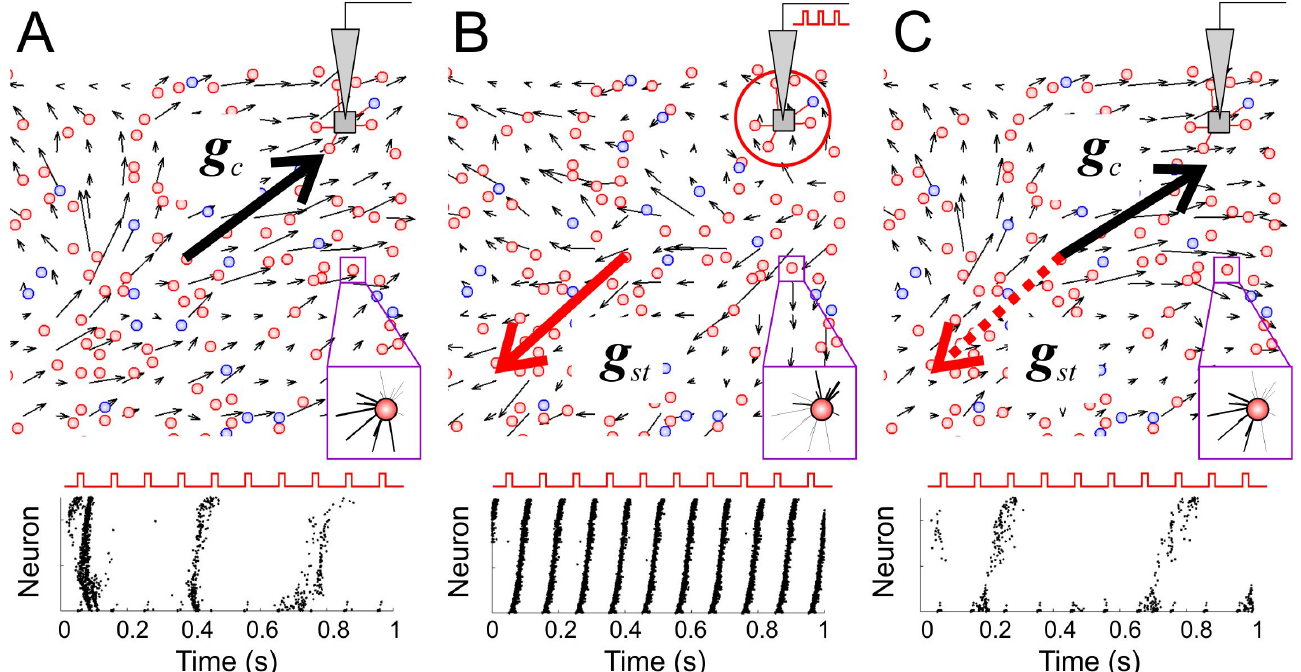
Figure 4. Characteristics of global network memory. ( A ) Top : The vector field of the synaptic weights (thin black arrows) of a segment of the neural network before external stimulation (only the first quadrant of the network is shown). The thick black arrow, g c , shows the global connectivity vector of the selected segment. The magenta-framed inset shows incoming couplings for a representative neuron (line thickness corresponds to the coupling weight). Bottom : A typical epoch of the raster plot during the stimulation (each point displays a spike of the corresponding neuron; neurons have been sorted by their distance to the stimulation site). ( B ) Same as in ( A ) but immediately after external stimulation. The thick red arrow, g st , is the vector of global memory after stimulation. ( C ) Same as in ( A ) but after a period of forgetting. The cosine of the angle between the connectivity vector at the current time g c (black) and the vector after stimulation g st (dashed, red) is the measure of global network memory.